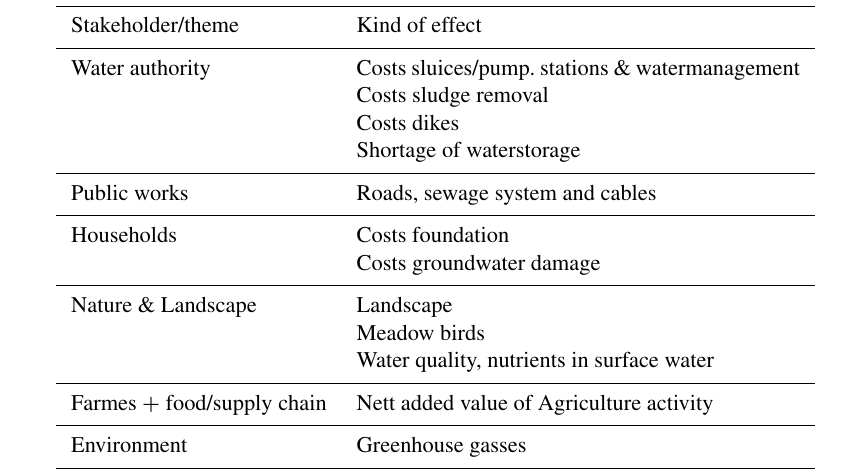
Table 2. Analyzed